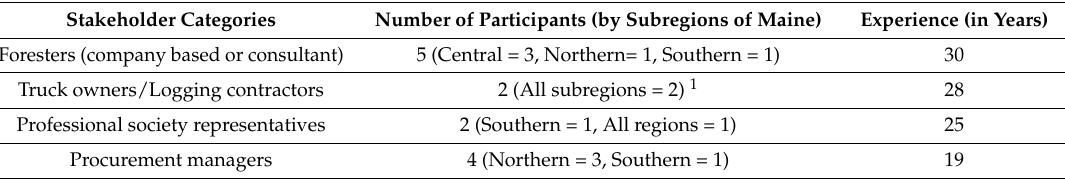
Table 1. Description of the participants interviewed for the study to comprehend the challenges faced by forest trucking sector and probable resolutions to those challenges. Stakeholder Categories Number of Participants (by Subregions of Maine) Experience (in Years) Foresters (company based or